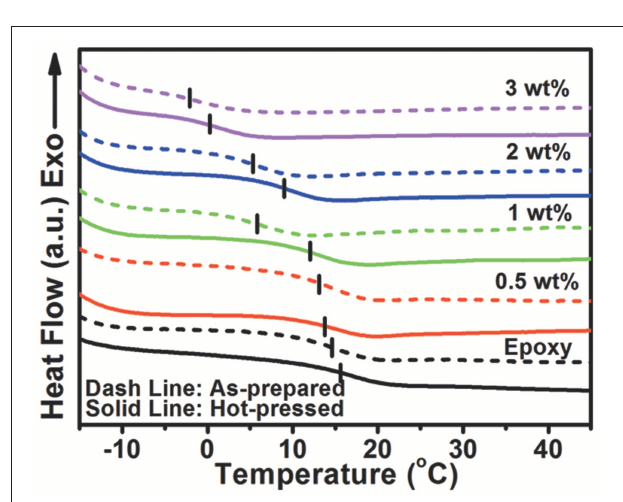
FIGURE 3 | DSC curves of as-prepared and hot-pressed GnP/epoxy